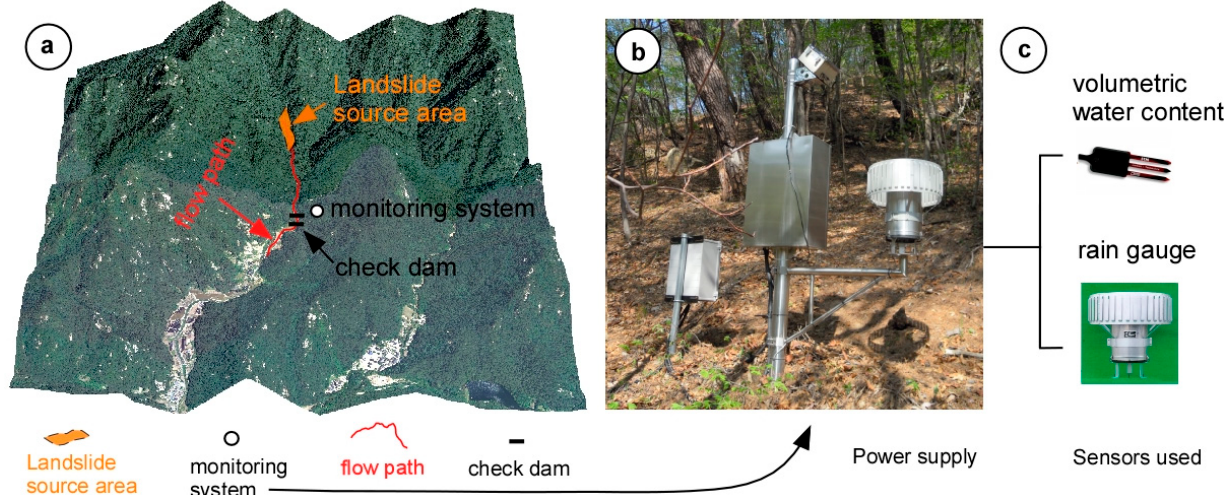
Figure 3. The Songnisan landside monitoring station: ( a ) areal overview, ( b ) power supply, and ( c ) sensors used.